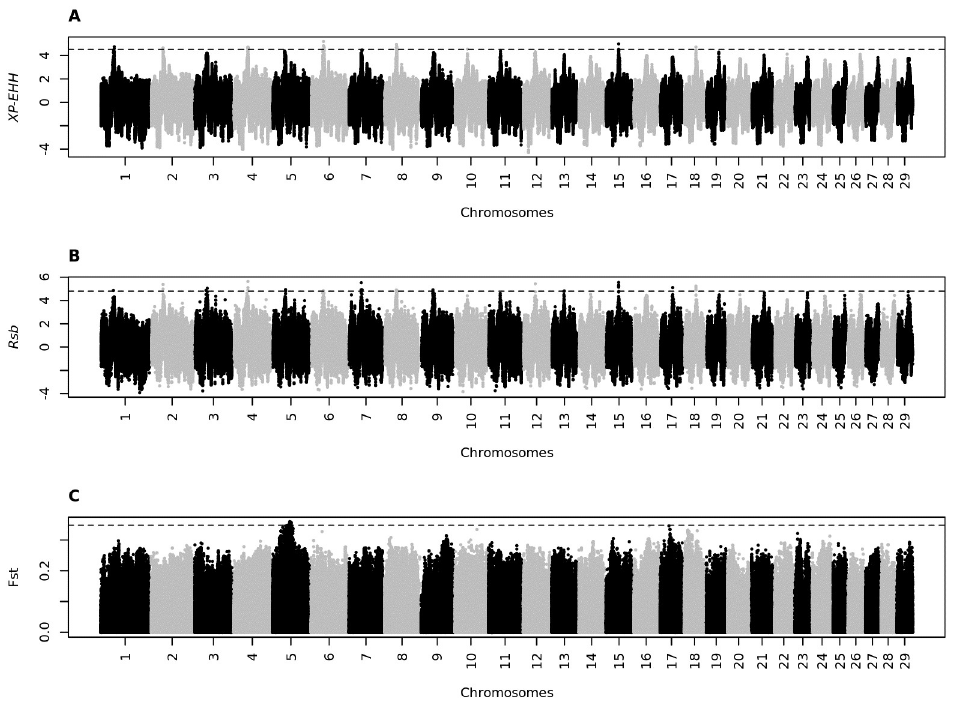
Fig 2. Manhattan plot for selection signature signals detected by the XP-EHH (A), Rsb (B), and Fst (C) methods for Canchim vs. Nelore.